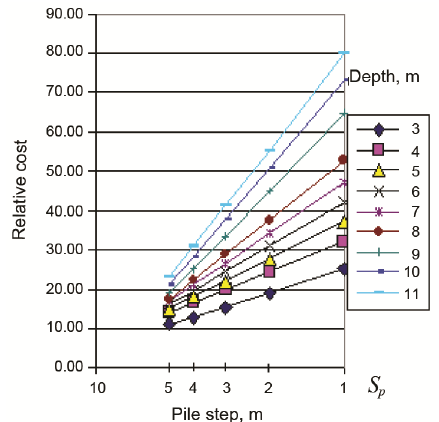
Fig. 7. Piles (with pile caps cast at place)